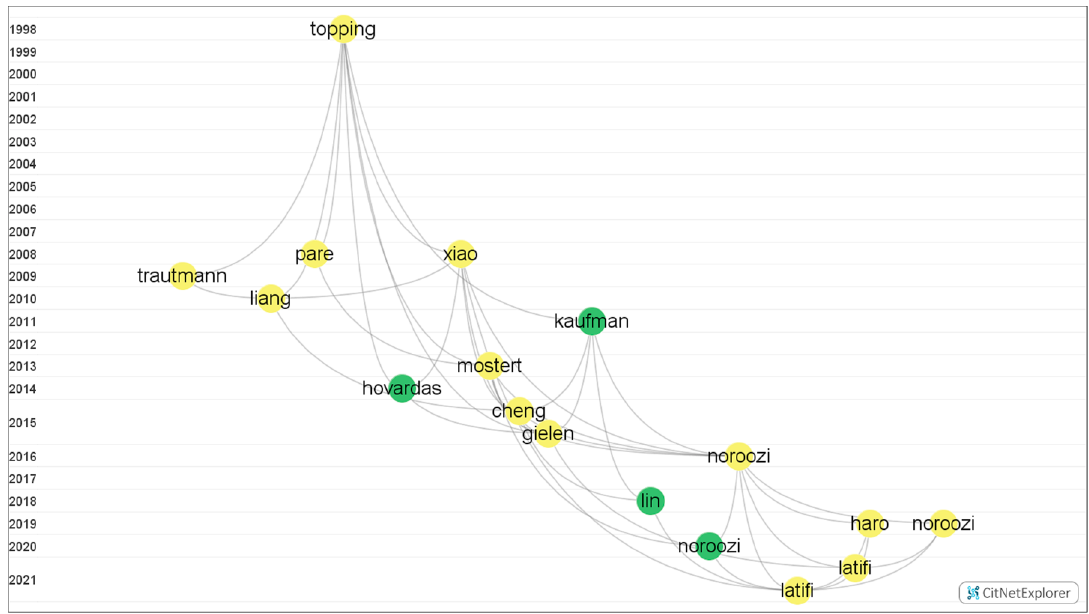
Figure 4. Multiple longest paths between Topping (1998) and Latifi et al. (2021). Table 6. Common citations in multiple longest paths between Topping (1998) and eight recent studies published in 2021 and 2022.